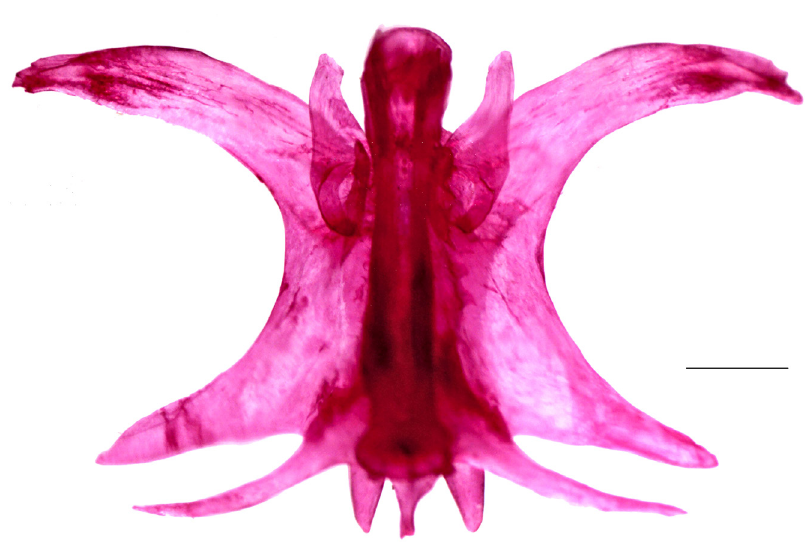
FIGURE 5 | Microglanis berbixae , MECN-DP 3762, paratype, 39.6 mm SL. Ventral view Weberian apparatus. Scale bar = 1 mm.